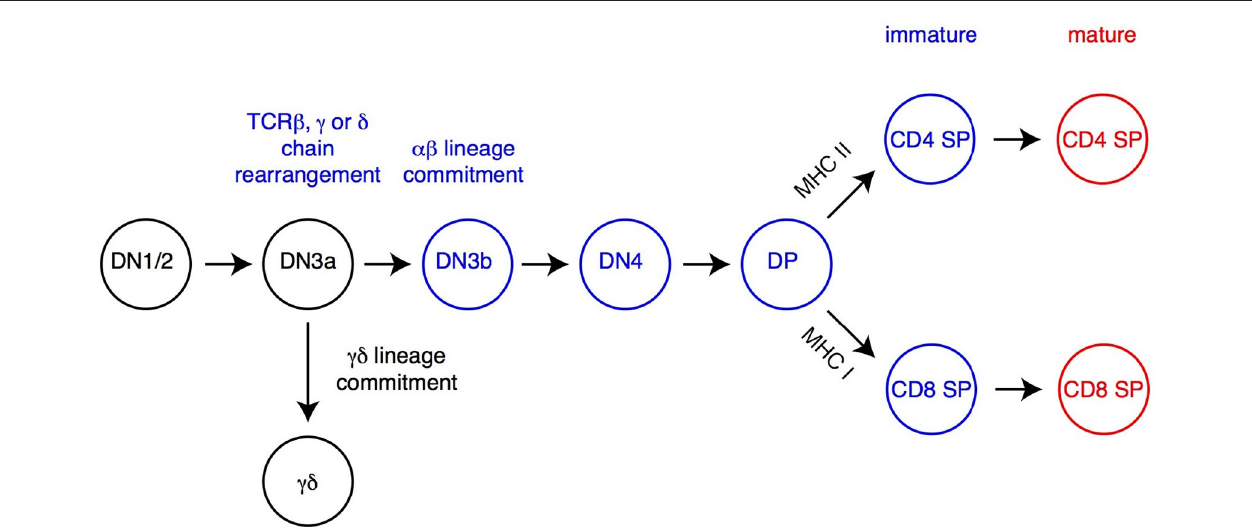
FIGURE 1 | Overview of T cell development. The most immature T cell precursors (CD4 − CD8 − DN thymocytes), CD4 + CD8 + DP and CD4 and CD8 SP thymocytes are depicted. Relevant DN thymocyte subsets (defined on expression of CD25 and CD44) are shown ( 14, 21). Commitment to either αβ or γδ lineage occurs after successful rearrangement, at the early DN3 stage (DN3a, characterized by low expression of surface markers CD27 and CD28), of the corresponding TCR chains (TCR β for αβ lineage cells, TCR γ and TCR δ for γδ lineage cells). DP thymocytes signaled by MHC-I or MHC-II-associated peptides undergo positive selection, differentiate into the CD8 or CD4 lineage (respectively) and complete their maturation before leaving the thymus. Cells signaled by high-affinity ligands are either deleted (negative selection, not depicted) or directed toward specific fates, including iNK T cells ( Figure 2 ) or regulatory T cells (Treg, not depicted).